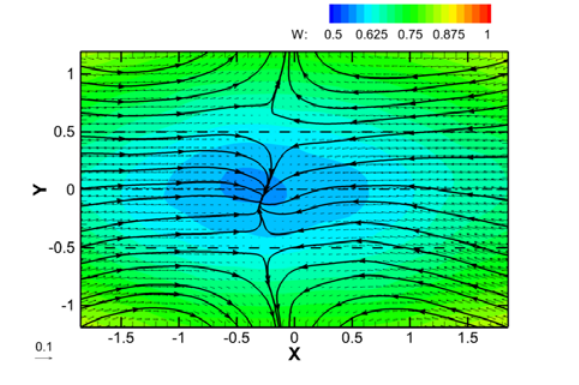
Fig. 2. Mean velocity distribution